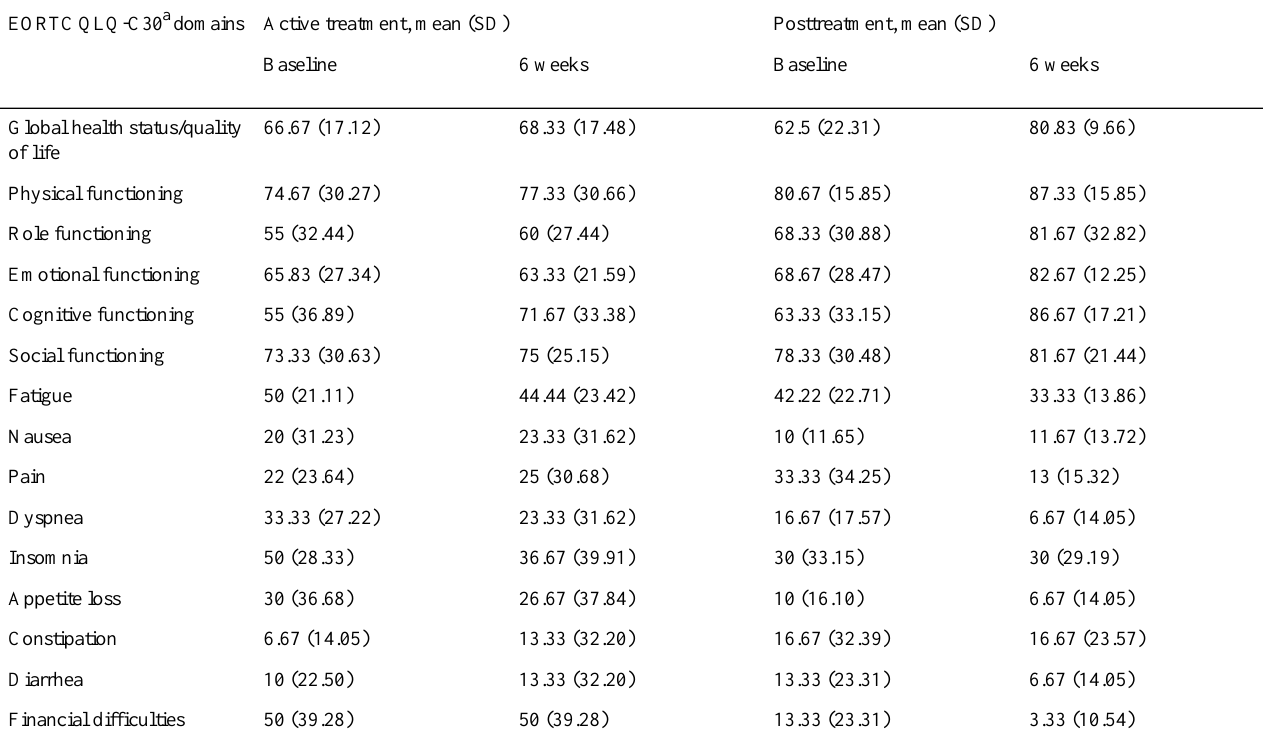
Table 2. Mean value for the 30-item European Organization for Research and Treatment of Cancer Quality of Life Questionnaire scales at baseline and 6-week